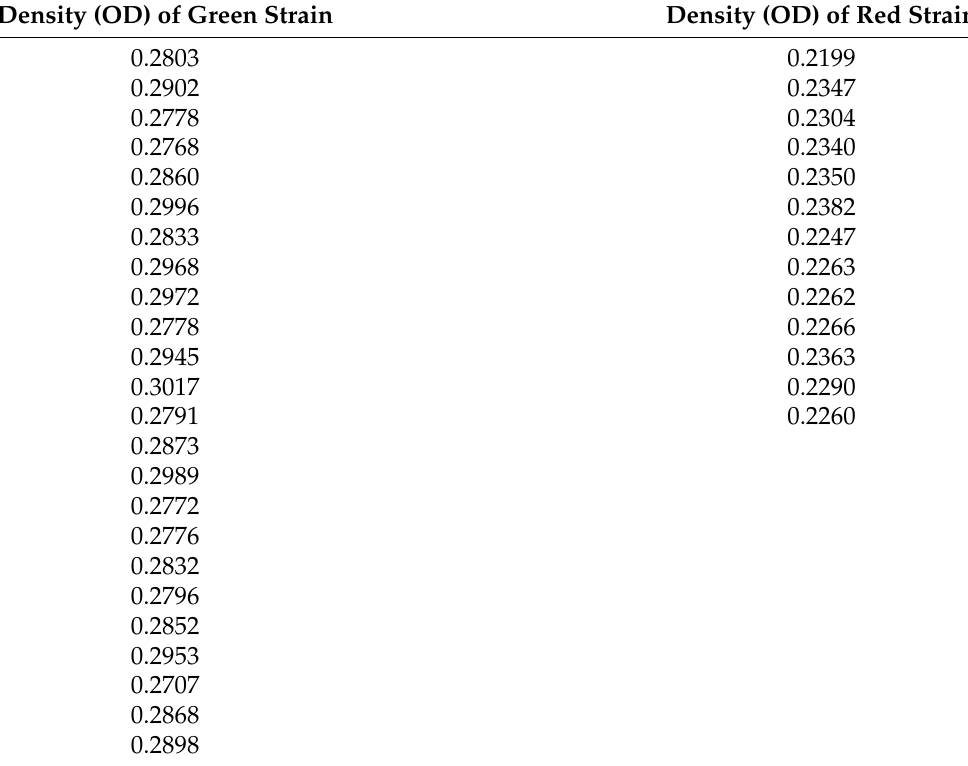
Table A1. Density (OD) measurements of the Green Strain and Red Strain at initial time ( t = 0 h). This data is used to estimate the parameters in Table 2. Note that more measurements were taken for the Green Strain than for the Red Strain. Complete data sources are available in